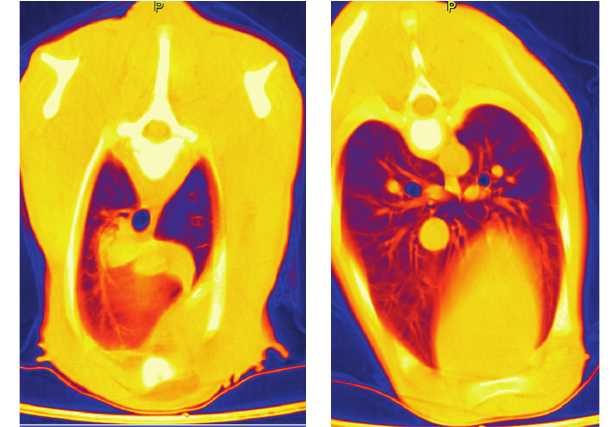
Figure 4: CT: thorax layer in false-color representation of a subject of group A at 1 week p.